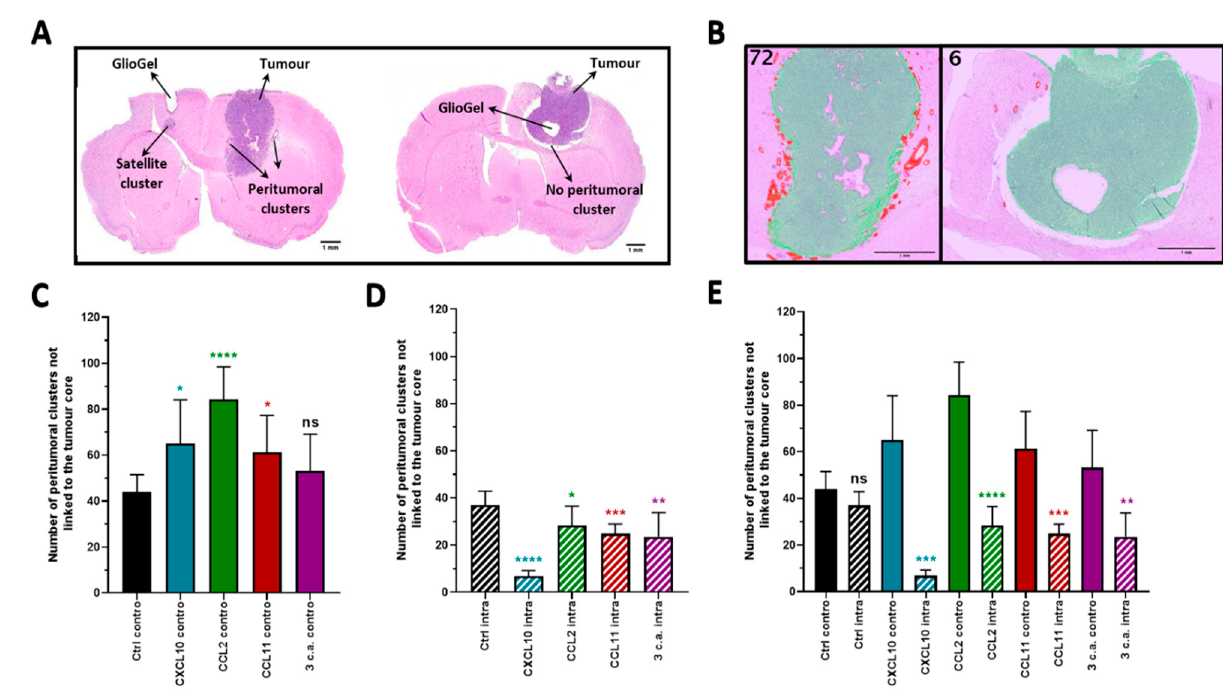
Figure 3. Brain histology of F98 glioma bearing rats for chemoattraction assays. Fischer rats were implanted with 10,000 F98 cells, GlioGel delivering chemoattractant were implanted 3 days later and brain collections were 12 days later (day 15 post tumor implantation) and processed for H&E coloration. ( A ) LEFT-GlioGel implanted into the controlateral hemisphere. The tumor has produced multiple peripheral clusters as well as satellite clusters in the controlateral hemisphere below the GlioGel inoculation point. RIGHT-GlioGel injected into the tumor (ipsilateral hemisphere). The tumor appears well restricted, showing almost no peripheral cluster. ( B ) Example of clusters count for ( A ) with the plugin Trainable Weka Segmentation in Fiji software. Red = clusters, Green = tumor core, Purple = brain background. ( C , D , E ) Glioma behavior according to the chemoattractant type and location. Contro = controlateral, Intra = intratumoral, Ctrl = Control, n = 7 to 10 animals depending on the group. *, p < 0.05, **, p < 0.01, ***, p < 0.001, ****, p < 0.0001, ns = not significant. The asterisk is added above the value compared to the control ( C and D ) or the corresponding “contro” group ( E ).